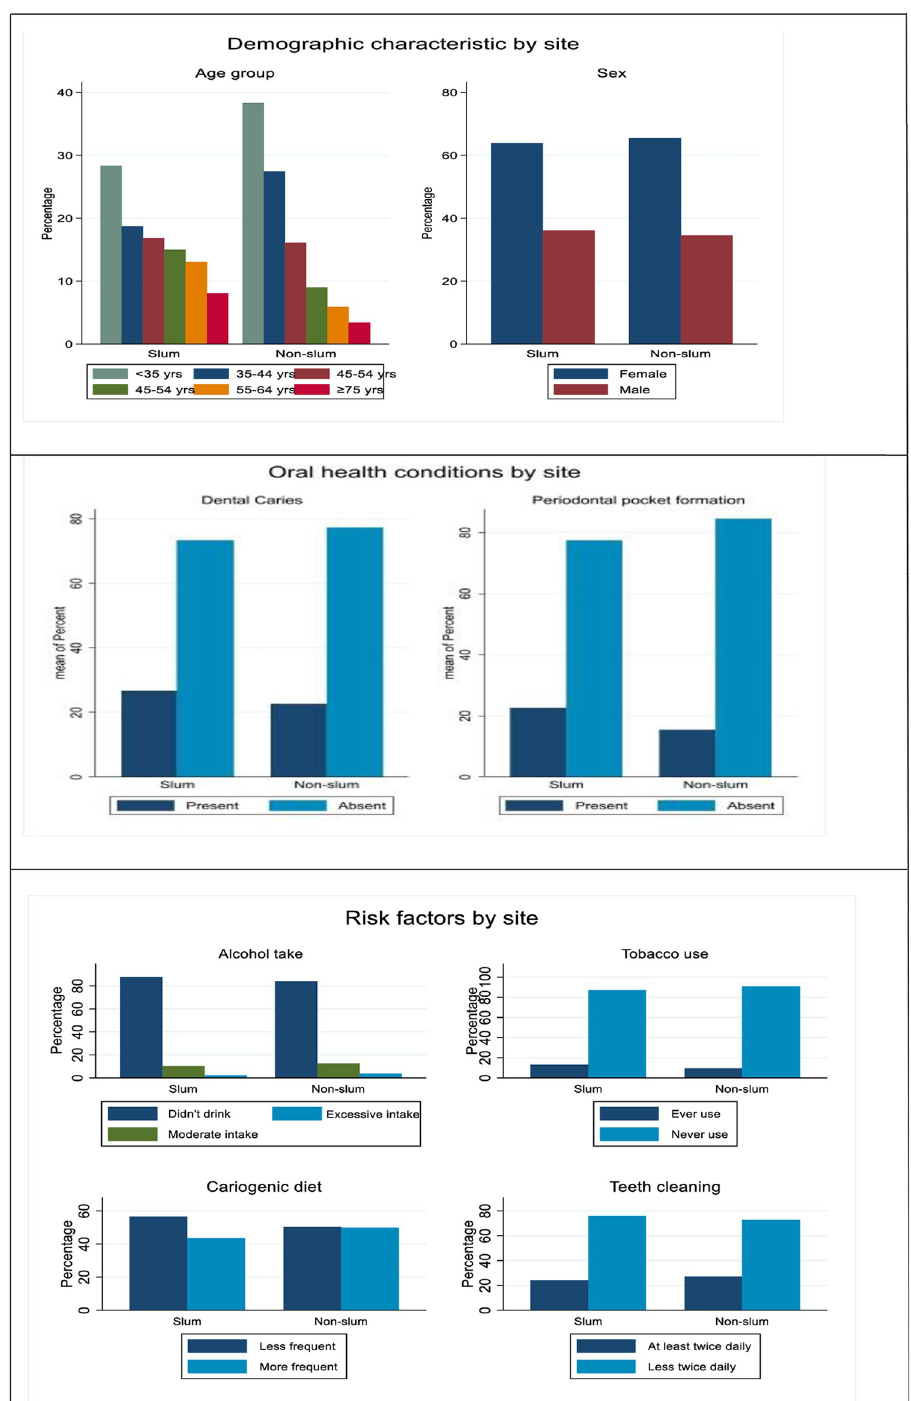
Fig 1. Distribution of key survey data (demographic characteristics, oral health conditions and risk factors) by slum versus non-slum site.